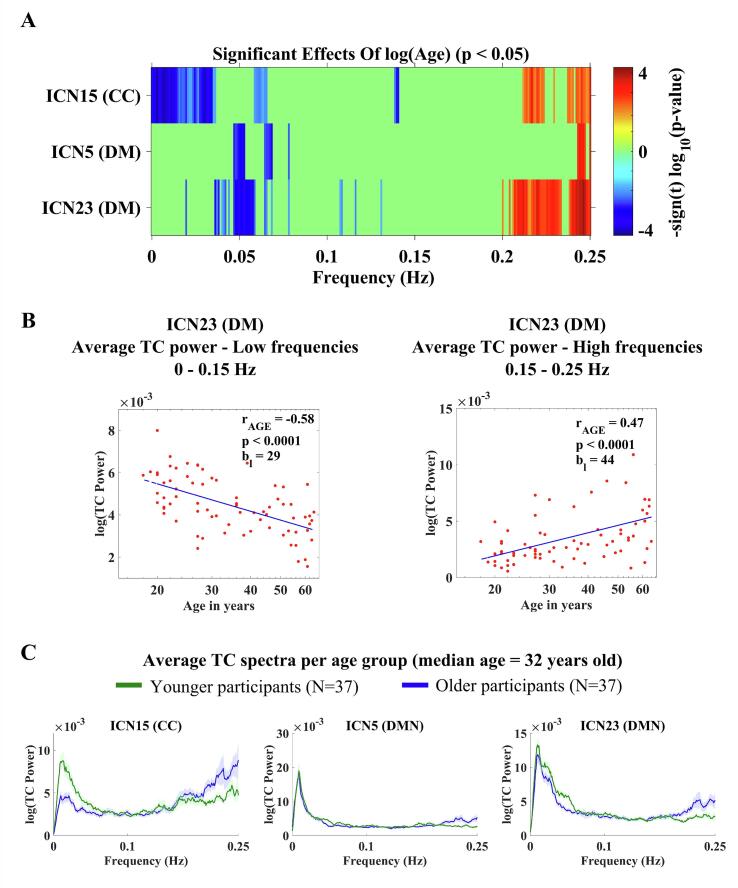
Effects of age on TC power spectra. (A): Effects of age for each IC TC power spectrum; the color bars display their significance and direction (p < 0.05, FDR-corrected). (B): Scatterplots depicting the significant results of changes in TC for increasing age for ICN23 (DM). (C): Line plots of the average TC power spectra of ICNs 5, 15 and 23 for younger and older participants based on median split (median age = 32 years old). The line plots show mean log(power) ± 1SE.